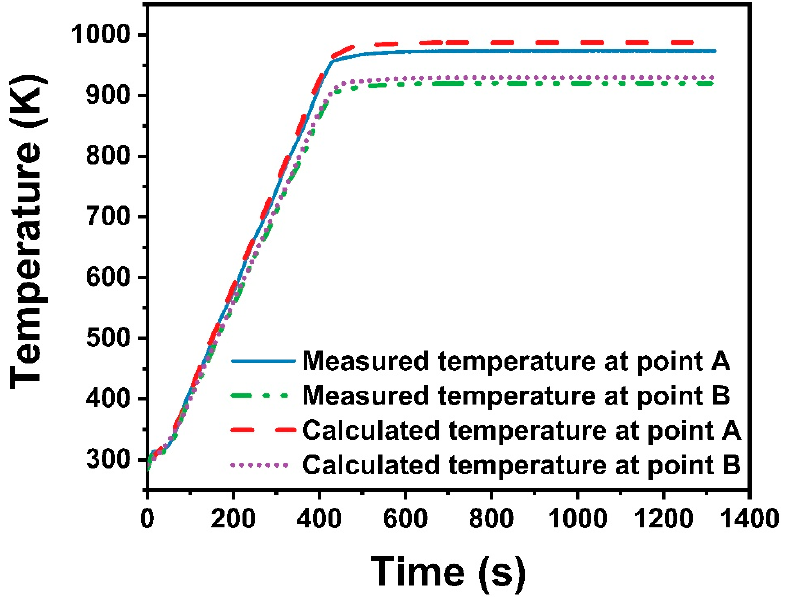
Figure 5. Validation of numerical results with experimental data. The temperatures measured at points A and B are compared with the simulated findings.